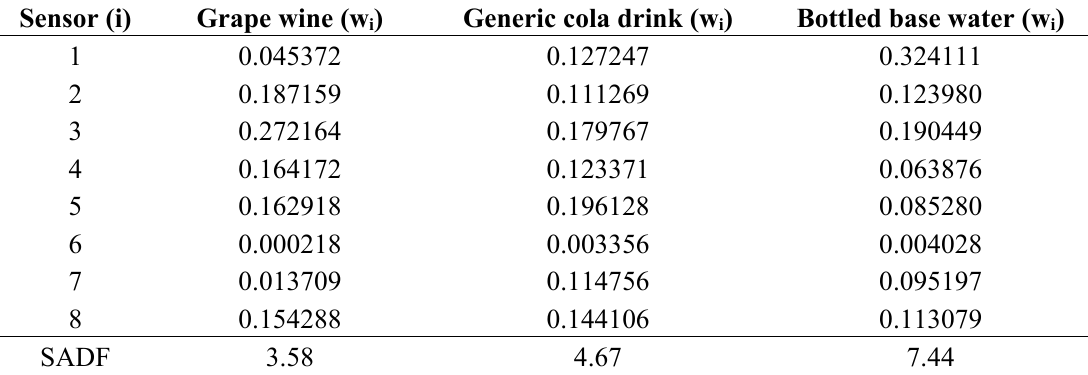
Table 3. The weighted coefficients of self-adaptive data fusion (SADF) for every sensor and used the pH measured data of grape wine, generic cola drink and bottled base water drinks to obtain fusion results.